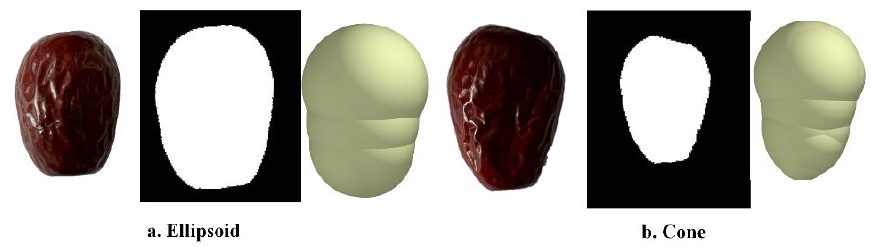
Figure 7. Schematic diagram of jujube simulation model.